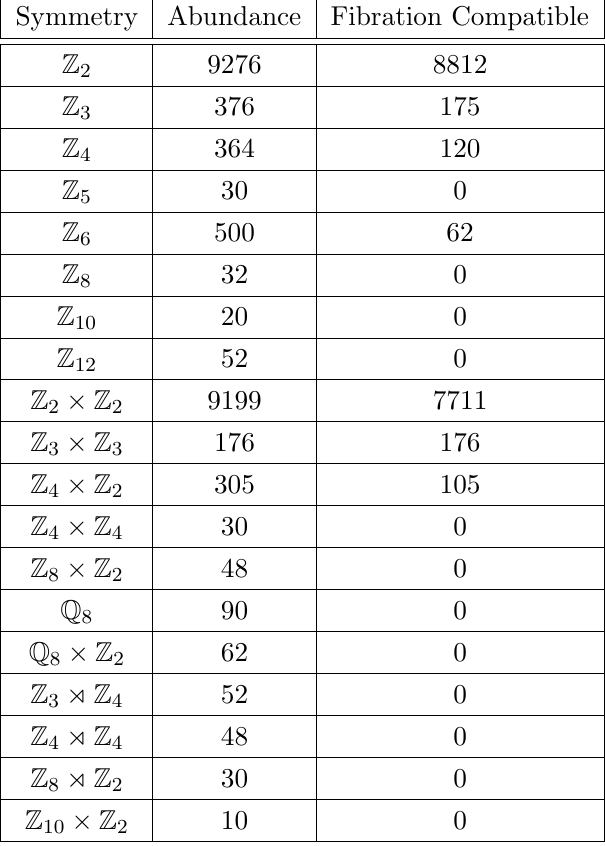
Table 1 . The number of (cid:12)brations that are compatible with each symmetry that appears in Braun’s classi(cid:12)cation [22]. \Abundance" denotes the number of (cid:12)brations appearing in CICYs admitting a given symmetry, and \Fibration Compatible" details how many of these (cid:12)brations are compatible with the symmetry and thus descend to the quotiented